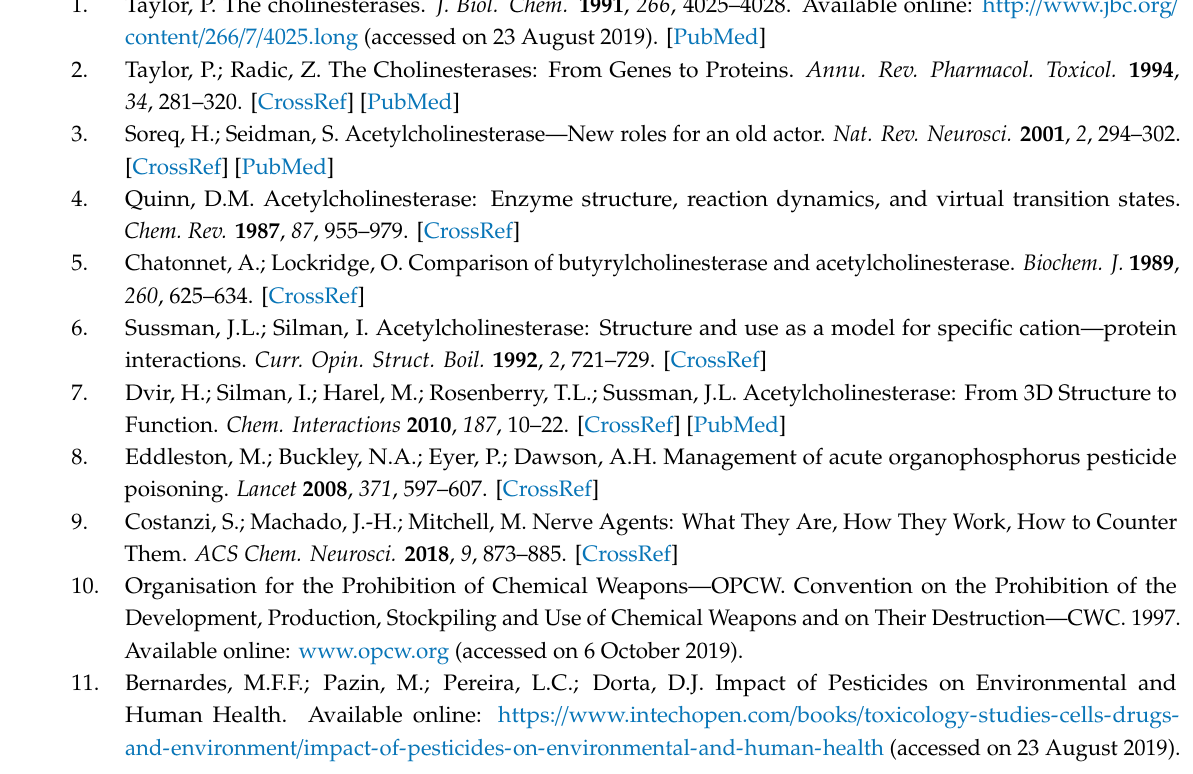
Table S1: Full results on inhibition of the Ee AChE with